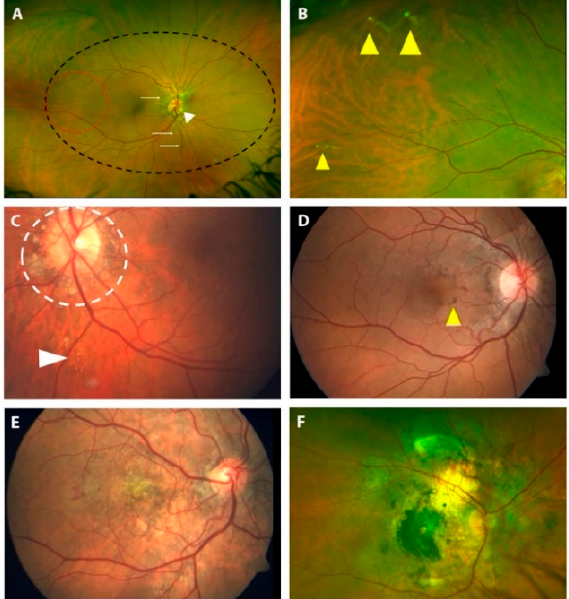
Figure 5. Color fundus photographs showing: ( A ) angioid streaks (white arrows), optic disc drusen (white arrowhead), peau d’orange (red circle) and coquille d’oeuf (black circle); ( B ) peripheral comet lesions (yellow arrowheads) as small, punctiform, whitish lesions; ( C ) peripapillary comet lesions (white circle) and comet rain (white arrowheads); ( D ) pattern dystrophy-like changes classified as “ fundus pulverulentus ” (yellow arrowhead); ( E ) choroidal neovascularization; ( F ) posterior pole atrophy.